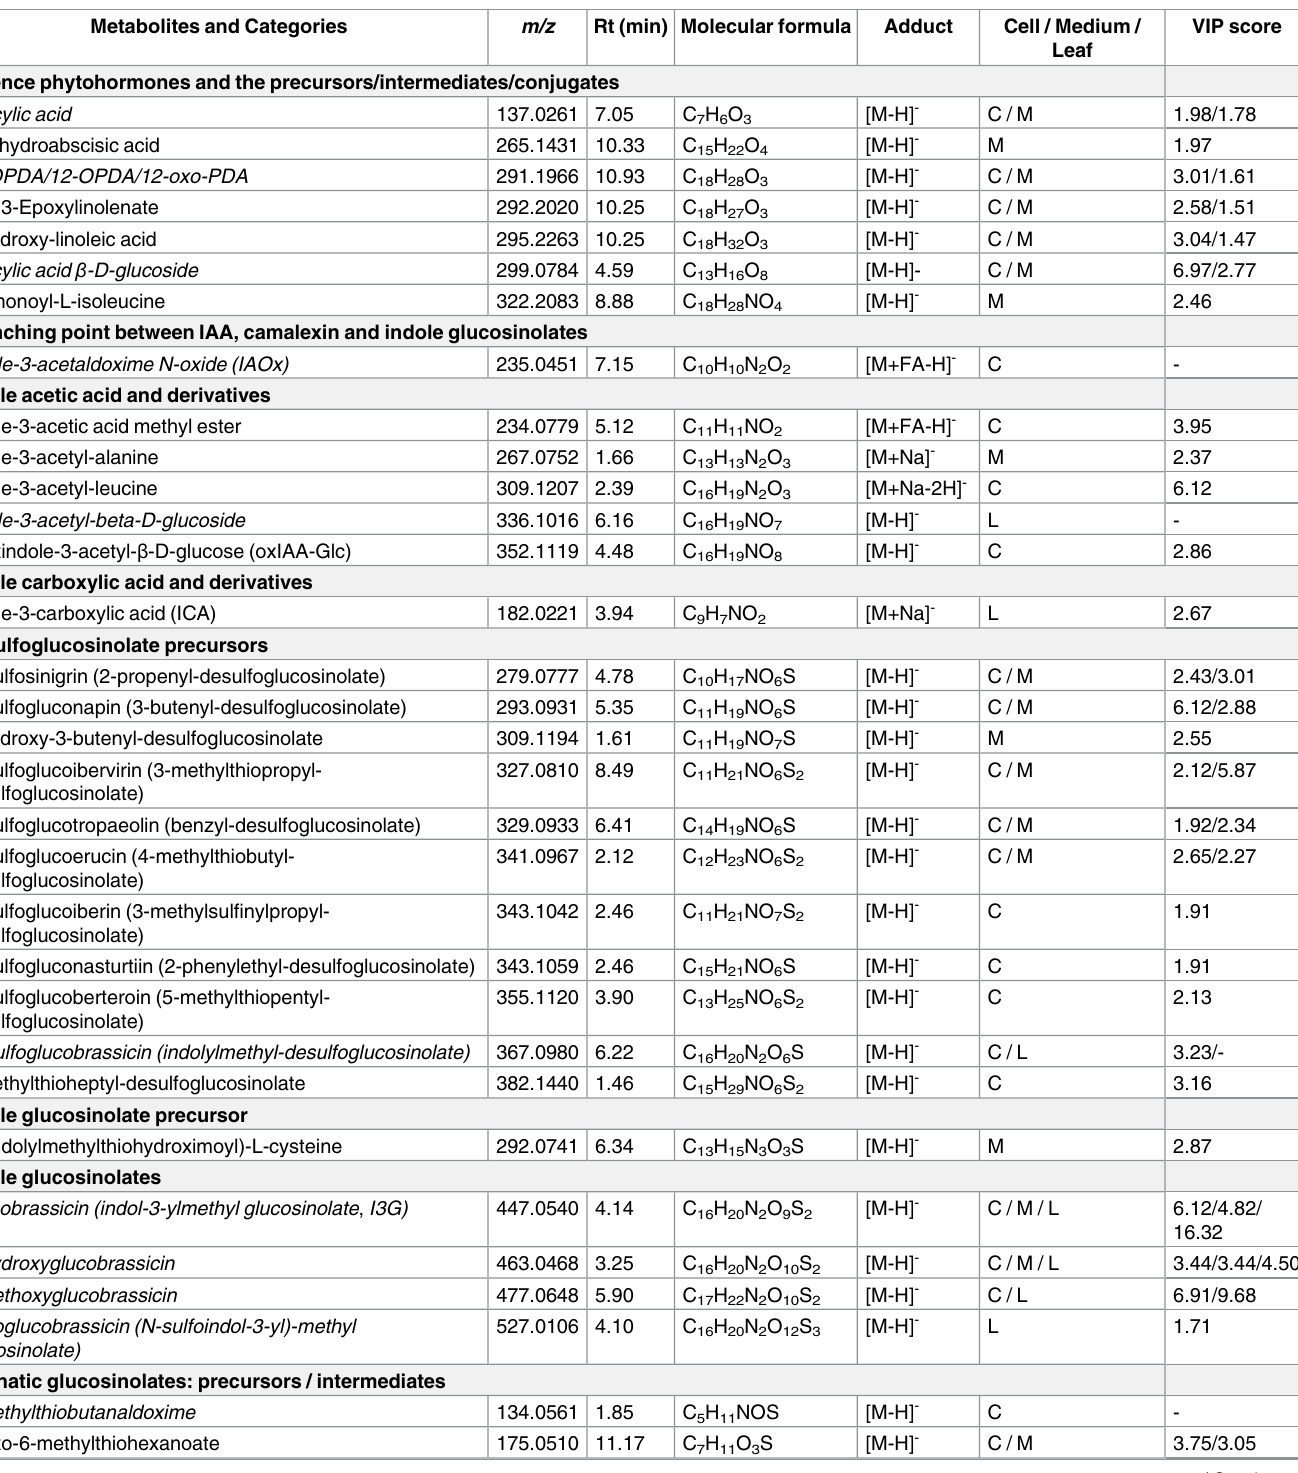
Table 1. Summary of annotated metabolites, analysed by high definition MS in ESI negative mode, in extracts from LPS-treated A . thaliana cells and leaf tissues. Metabolites that contributed to the discriminating variability in the altered metabolomes were identifiedbased on OPLS-DA S plots, with VIP-score values > 1 indicated.Metabolites annotatedfrom volcano plots are indicated in italics . Annotations correspond to the metaboliteidentification(MI)- level 2